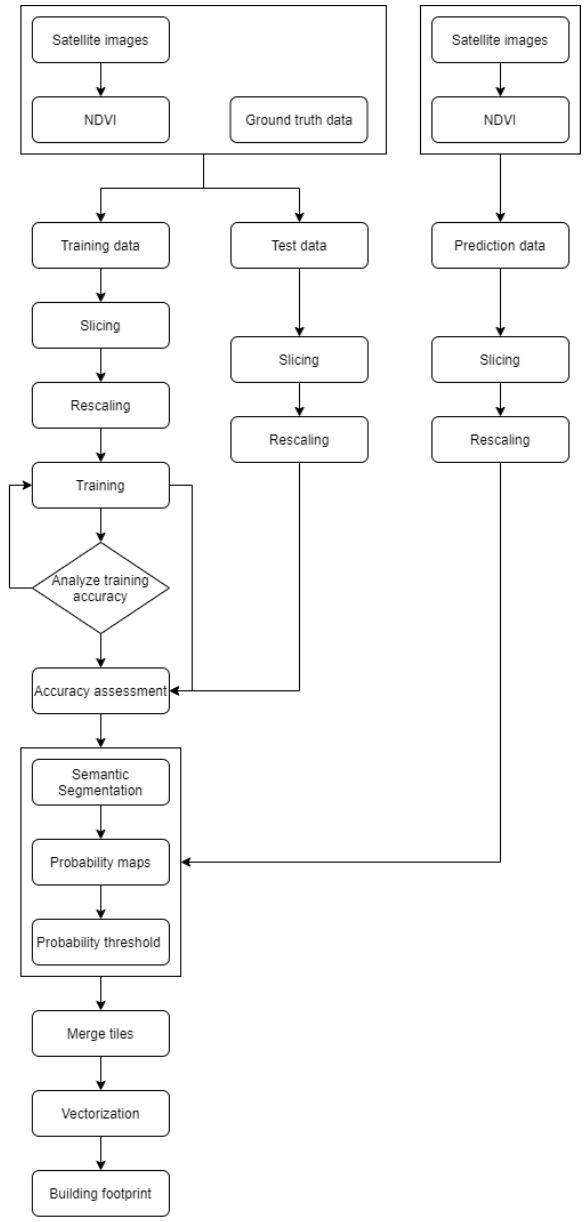
Figure 5. Extracting footprints of buildings using U-net.